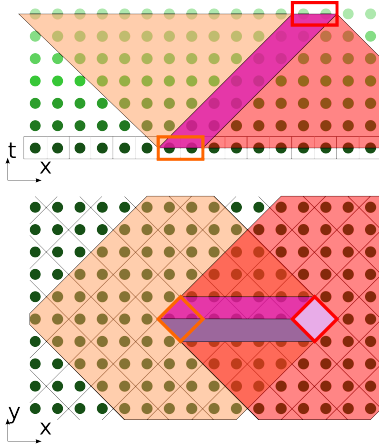
Figure 5. DiamondTorre algorithm construction as an intersection of an influence cone (orange)